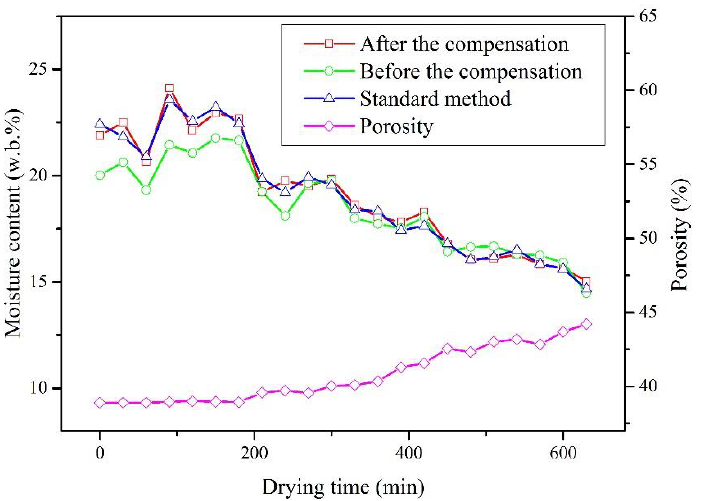
Figure 8. Comparison of discharged grain moisture content determined by the online method and the standard